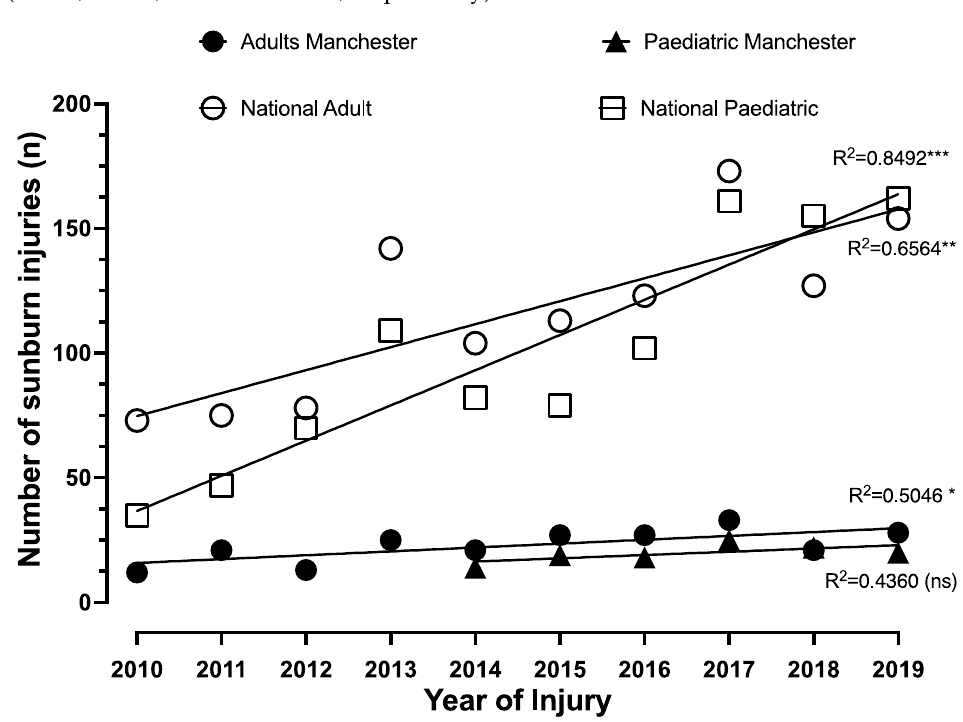
Figure 6. Temporal pattern in sunburn injuries comparing local (Greater Manchester) and National data from iBID for adult and paediatric patients demonstrating increasing trend over time (R 2 value of linear correlation, *** p < 0.0005, ** p < 0.005, * p < 0.05).